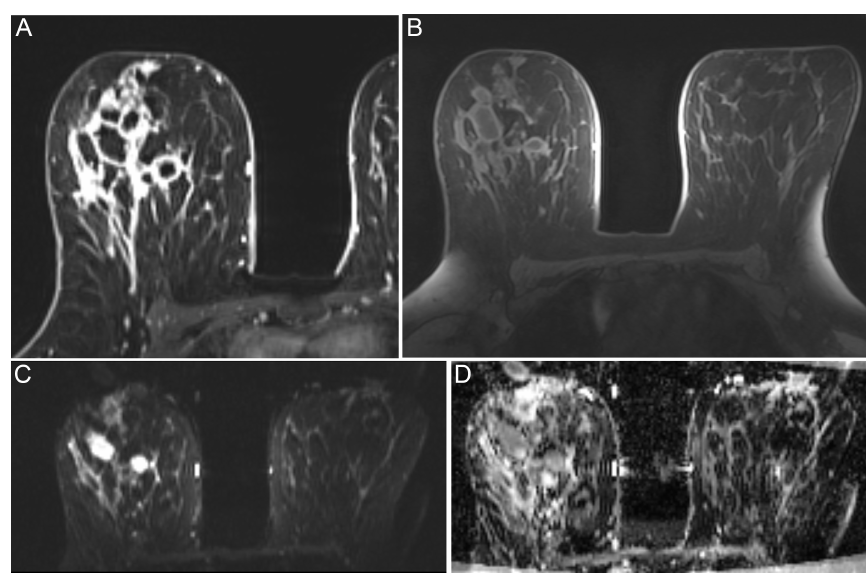
Figure 3. A-D. Idiopathic granulomatous mastitis (IGM) in a 24-year-old patient with a persistent history of IGM on the right breast for the past 3.2 years. A thorough evaluation was not yielding for any etiologic agent. The lesions on magnetic resonance imaging (MRI) show extensive segmental involvement with diffuse contrast enhancement on (A) flow dynamic and (B) post-contrast subtraction images. The mass shows restricted diffusion on (C), axially acquired image from diffusion-weighted MRI ( b = 800 s/mm 2 ) and a low apparent diffusion coefficient on (D). The patient underwent 5 courses of intralesional steroid injection therapy and no relapse was noted on 3 years of follow-up.